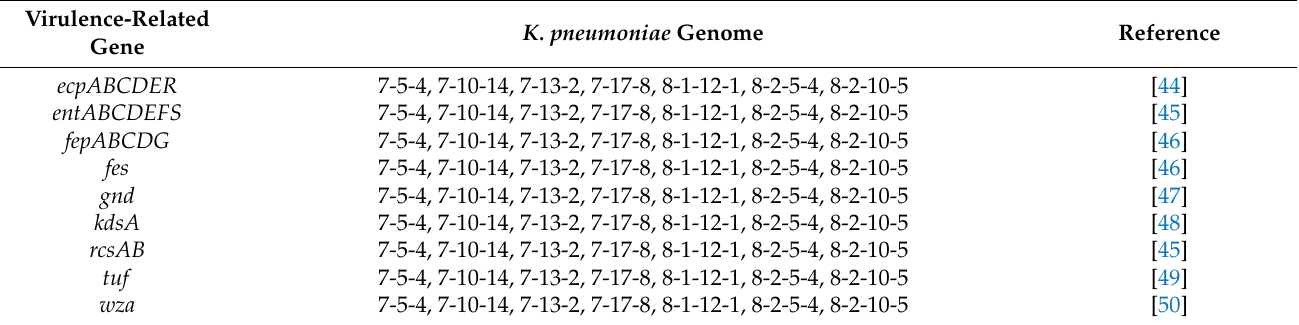
Table 2. The putative virulence-related genes identified in the K. pneumoniae